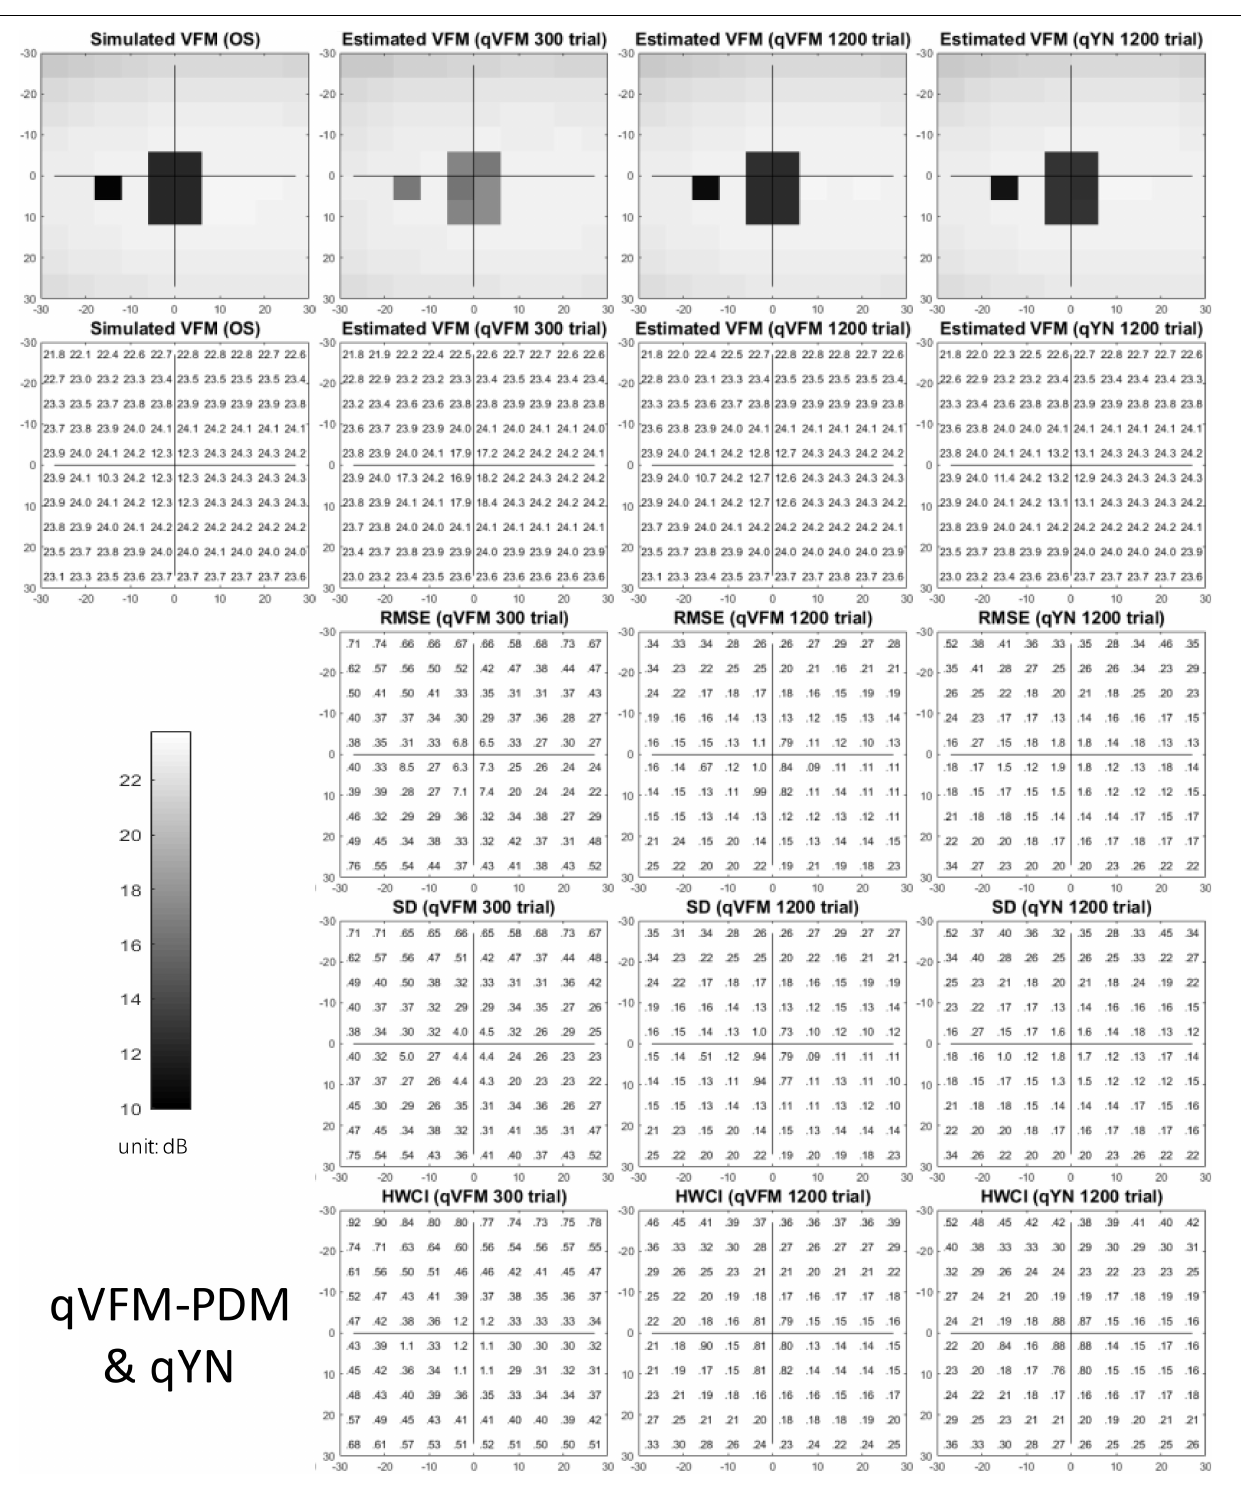
Frontiers in Neuroscience |